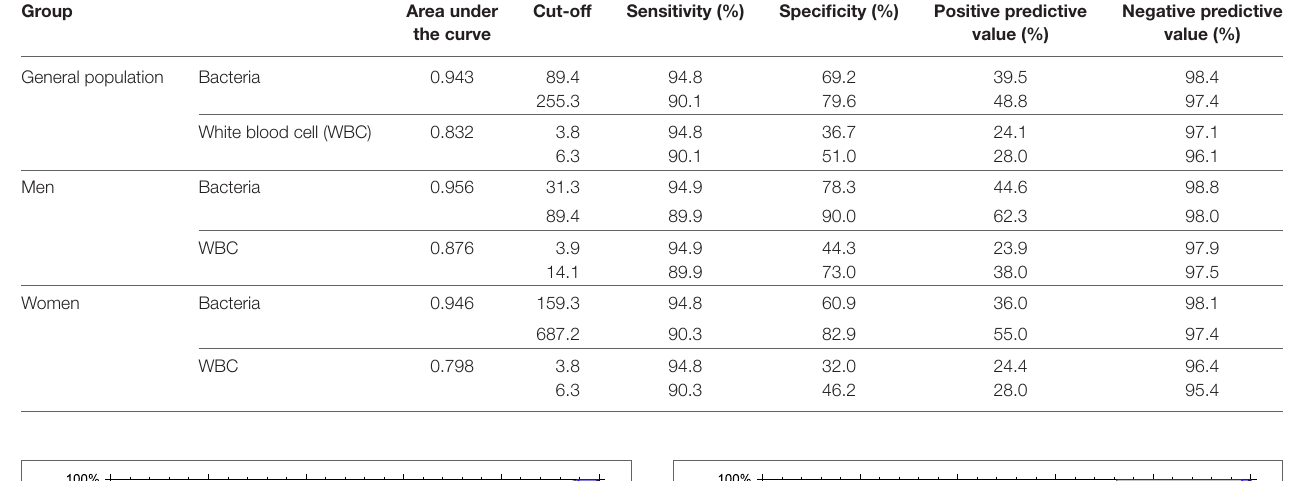
negative predictive value (%) value (%)